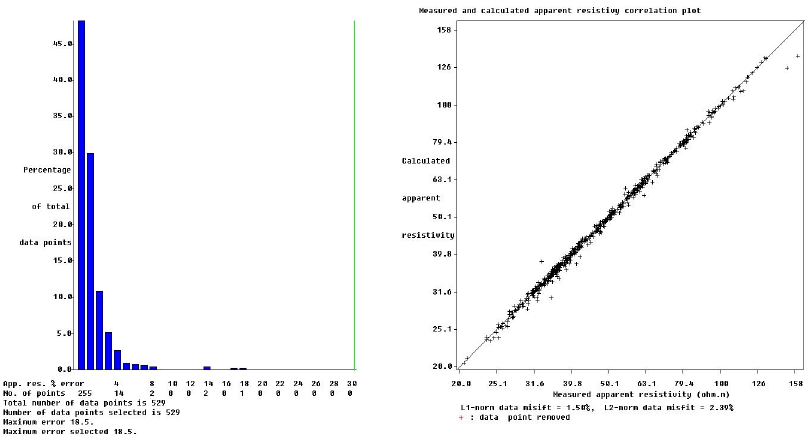
Figure 16. The results of the statistical analysis of errors in fitting the inversion model to the appar-